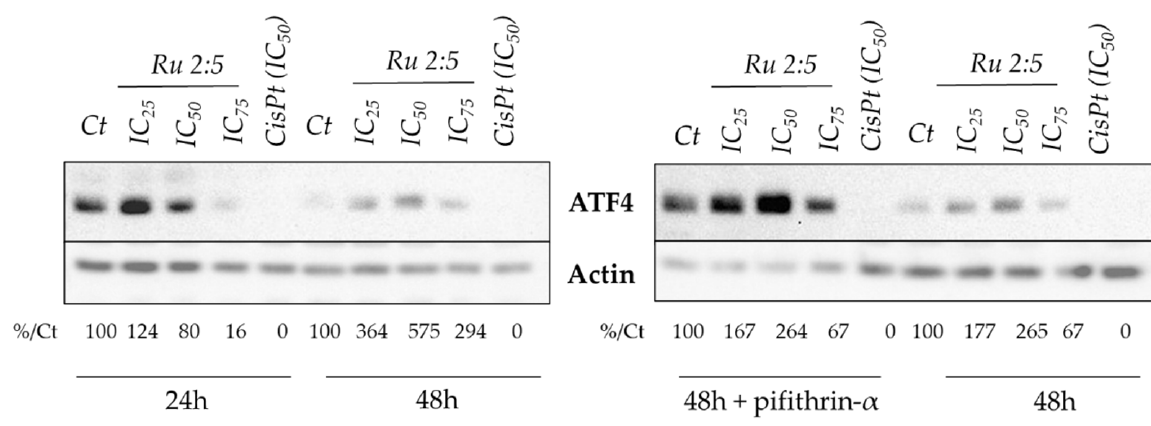
Figure 6. Expression of the ER stress biomarker ATF4 after treatment with Ru 2:5 in HCT116 cell lines. Cisplatin was used as positive control (IC 50 ). This image is representative of three independent experiments.